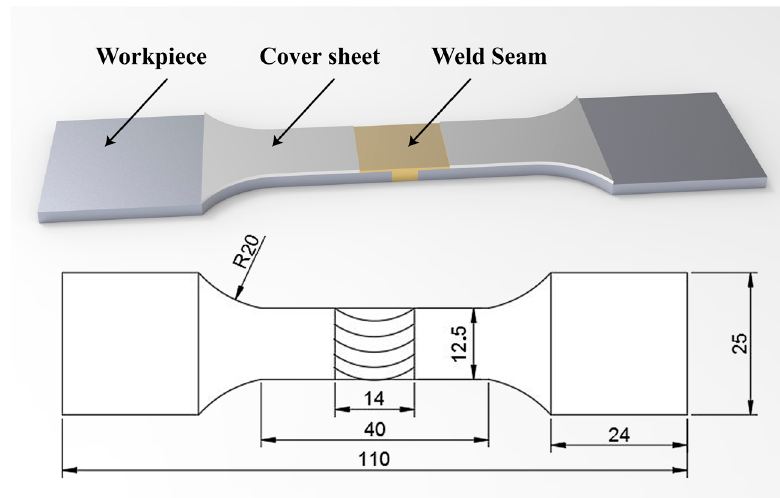
Figure 2. Dimensions of the tensile specimens.